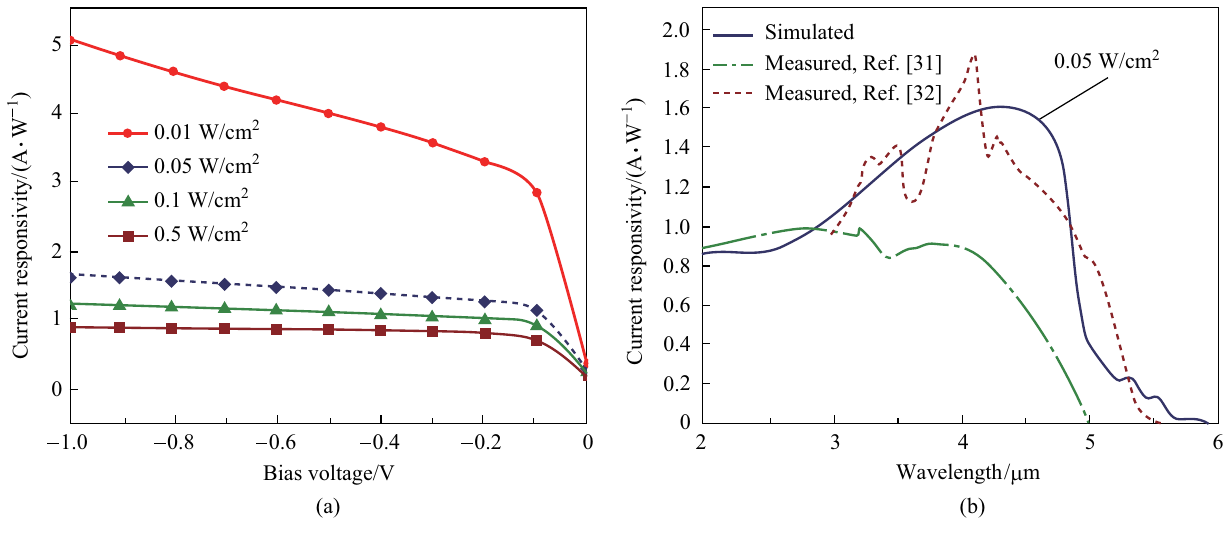
Fig. 5 Current responsivity of the δ-DCGB nBn-PD device at 150 K. a Responsivity versus applied bias voltages for different incident light intensities. b Simulated spectral response compared to the measured